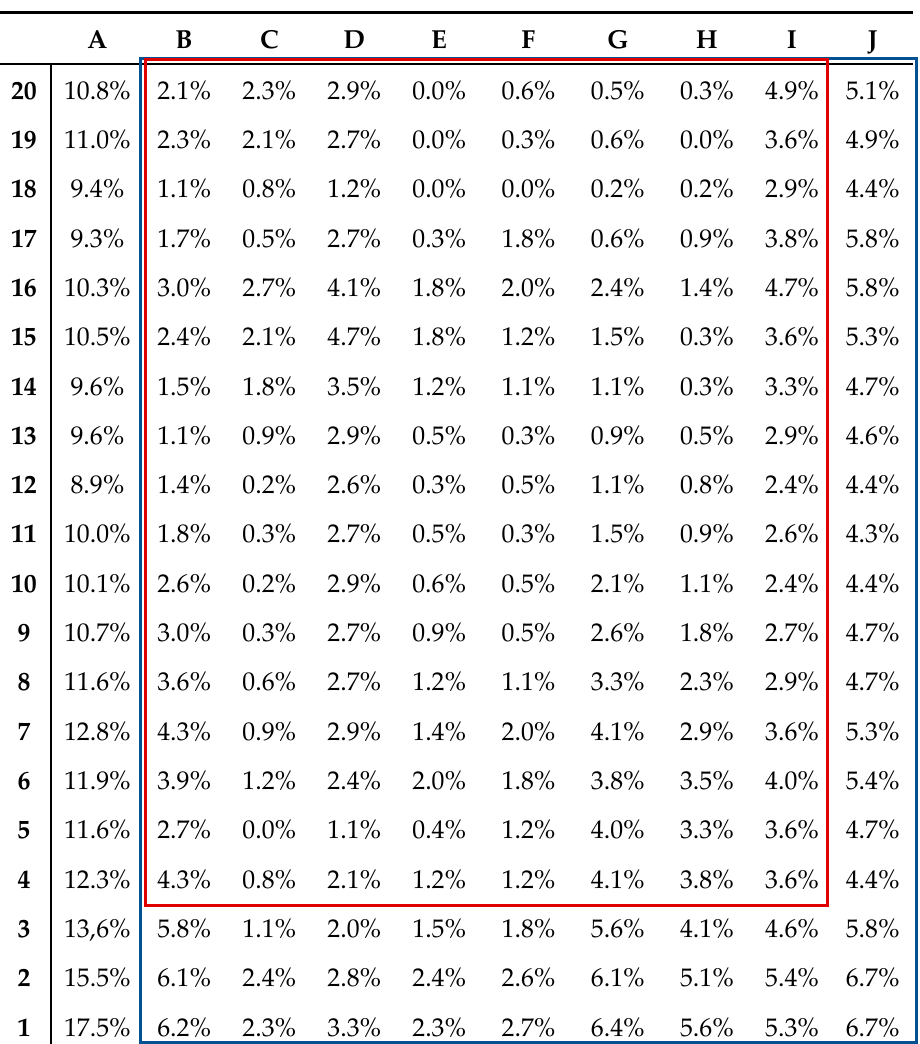
Table 2. The percentage error of irradiation. The blue rectangle indicates the Class C standard area obtained, the red one the Class B.